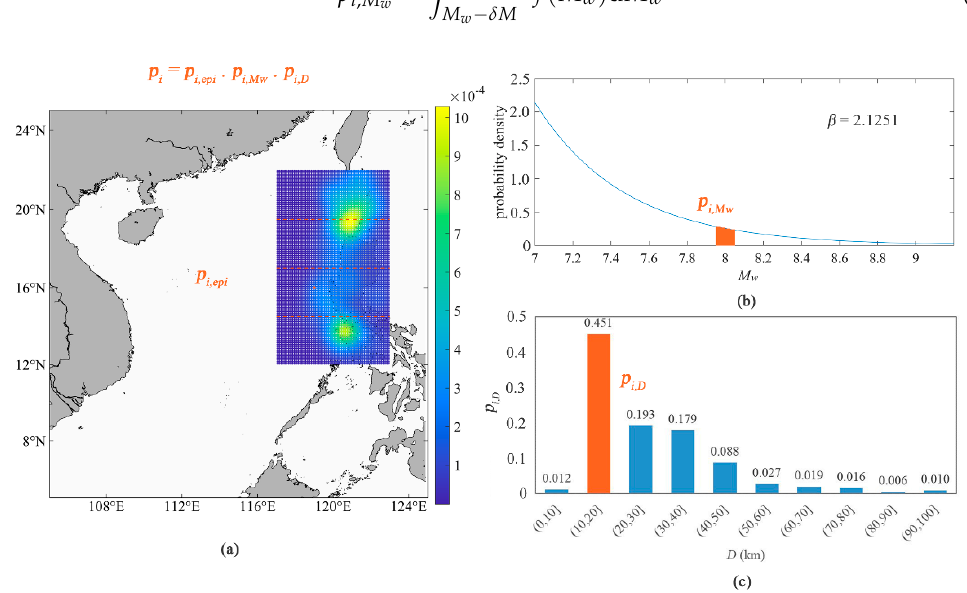
Figure 3. Occurrence probability of each source parameter: ( a ) epicenter; ( b ) moment magnitude ( c ) focal depth.